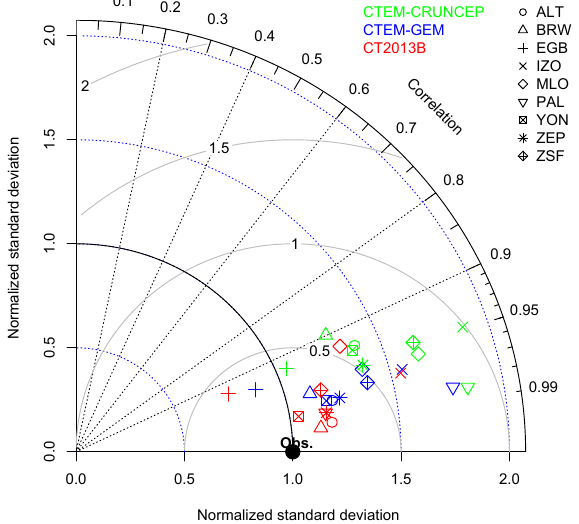
Figure 11. Taylor diagram of modeled monthly CO 2 concentrations produced by a forward run of GEM-MACH-GHG using land fluxes from CT2013B (red), CTEM-GEM (blue), and CTEM-CRUNCEP (green) and observed CO 2 (identified as “1.0”) at selected sites (shapes) (listed in Table